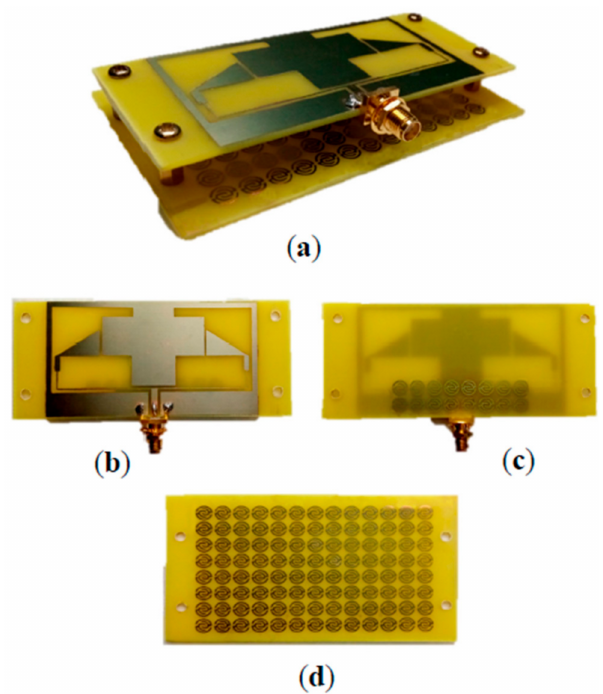
Figure 11. The fabricated prototype of the proposed coplanar waveguide (CPW) antenna: ( a ) 3D view; ( b ) front view; ( c ) back view with MTM; and ( d ) MTM super substrate structure.